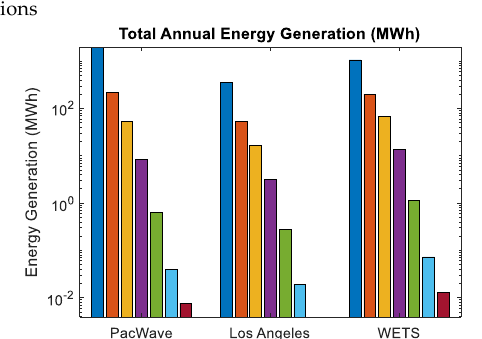
Figure 10: Logarithmic plot of total energy generation for various WEC size and